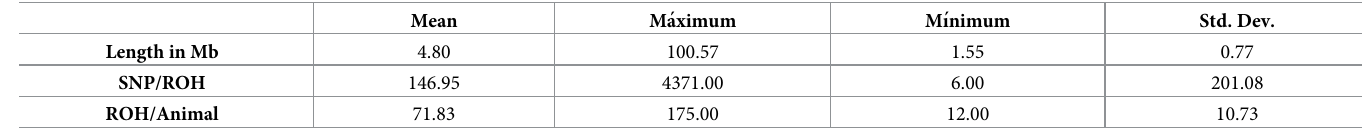
Table 1. Average length and SNP number per ROH, and number of ROH per animal in the Mexican Holstein population. Mean Ma´ximum Std.